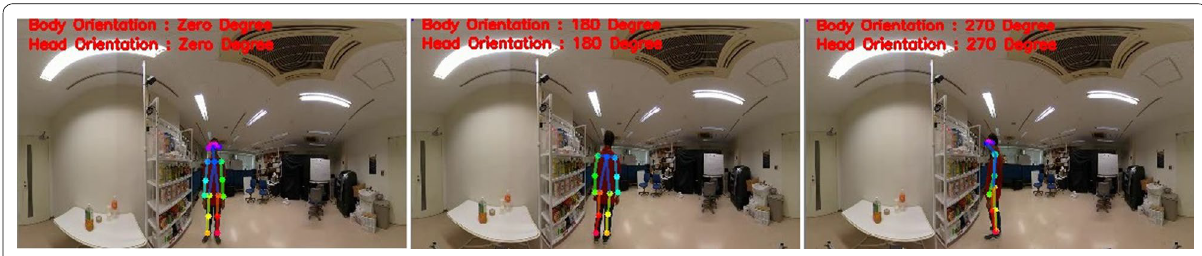
Fig. 5 Detection results of head and body orientation